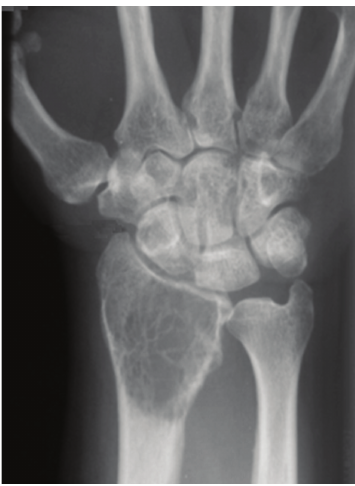
Figure 1: Preoperative radiographs demonstrating a giant cell tumour of the distal radius (seen as a classic lytic lesion).